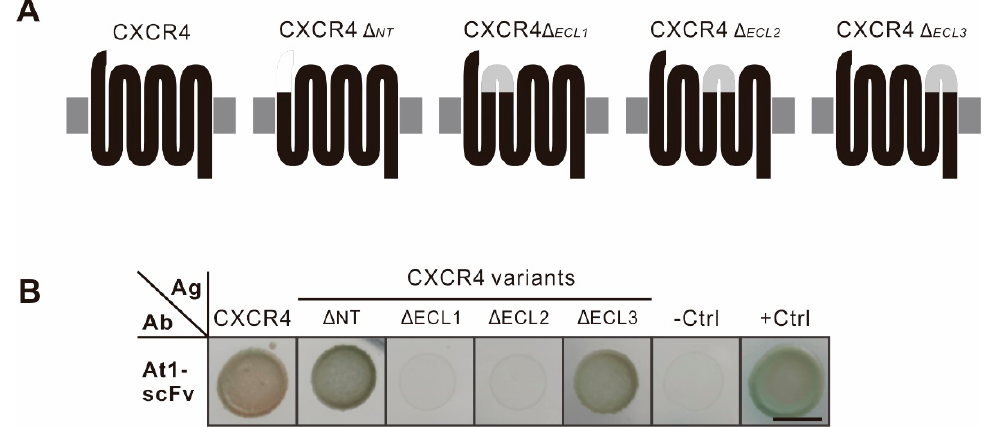
Figure 7. Determination of CXCR4 epitopes that mediate antigen-antibody interaction. ( A ) Diagram of CXCR4 mutants. Four extracellular fragments of CXCR4 were substituted with 2 × GGGGS flexible peptides, named CXCR4 ∆ NT , CXCR4 ∆ ECL1 , CXCR4 ∆ ECL2 , and CXCR4 ∆ ECL3 , respectively. ( B ) Interaction assay. The interaction between mutant CXCR4 and its specific antibody, At1, was detected in the AACD system. The CXCR4 mutants were cloned into the antigen module, and their interaction with At1-scFv was detected. The interactions among CXCR4 ∆ ECL1 , CXCR4 ∆ ECL2 , and At1-scFv were hindered. The positive and negative controls were the same as in Figure 5C. The experiments were performed in triplicate. The bar indicates 5 mm.